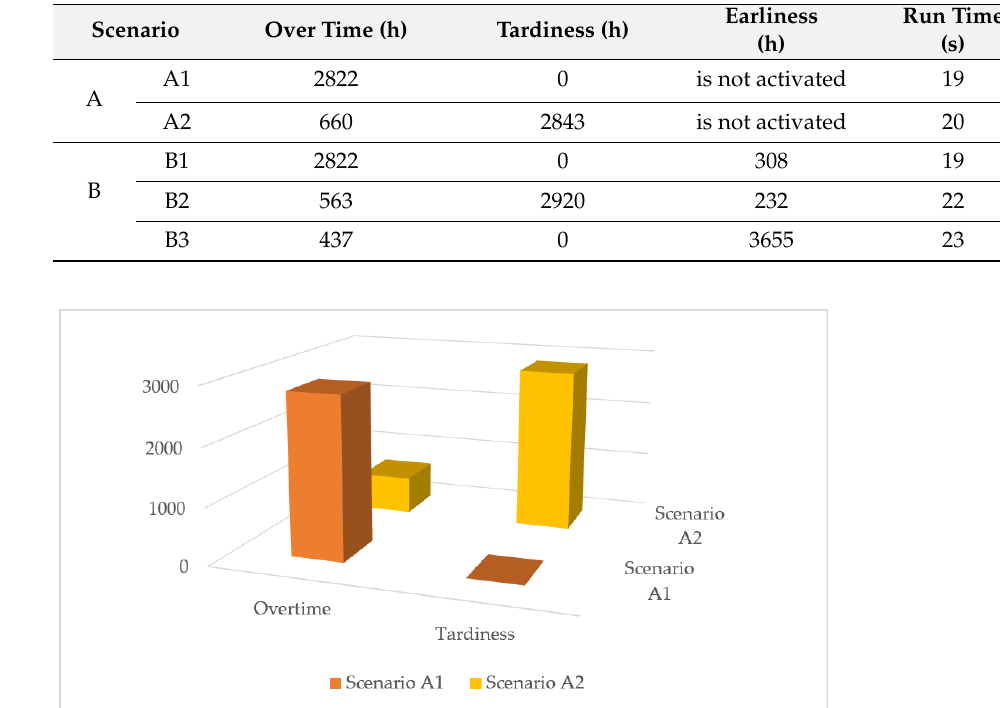
Table 6. Computational results for “Case study”.